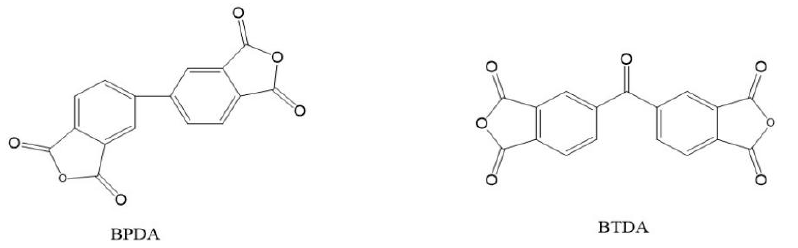
Figure 2. Main monomer structures in group 2 and group 3. Table 1. Simulation results of the polarizability of PI films composed of each monomer group.